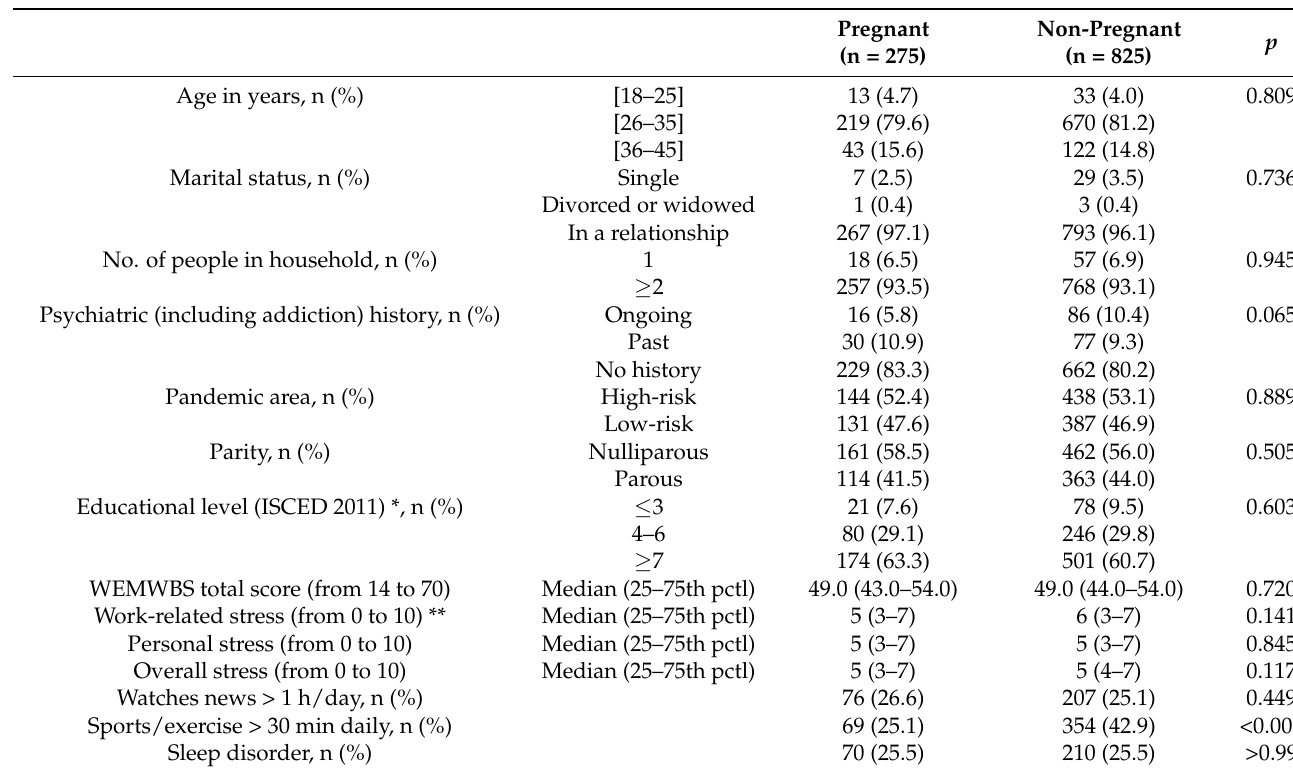
Table 1. Characteristics of study participants by pregnancy status.